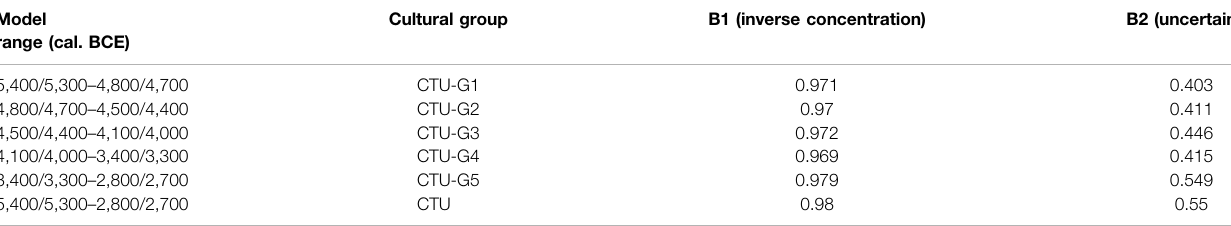
TABLE 7 | Niche breadth statistics (after Levins, 1968; Whitford, 2019). Model range (cal. BCE)